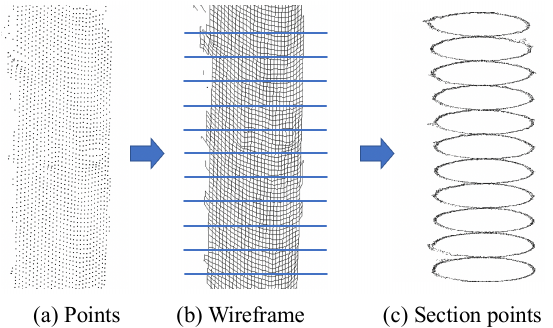
Figure 6. Cross section points with horizontal